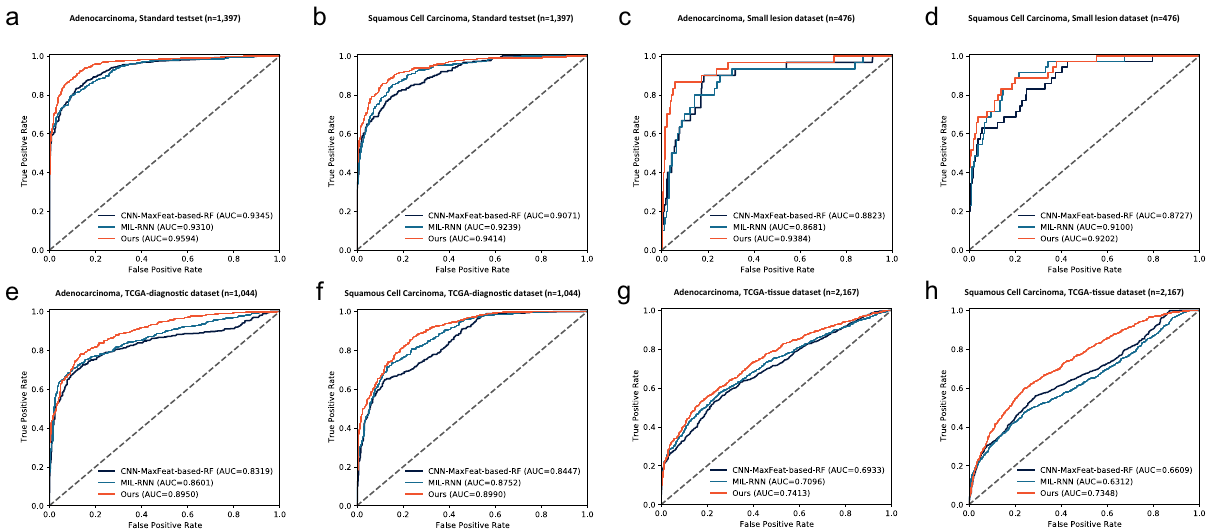
Fig. 2 Receiver operating characteristic (ROC) curves of methods on classifying adenocarcinoma and squamous cell carcinoma. Area under the ROC curve (AUC) was measured for each data set and method. All the measurements were taken from distinct samples. a , b ROC curves on the standard testing data set ( n = 1397). c , d ROC curves on the small lesion data set ( n = 476). e , f ROC curves on TCGA-diagnostic data set ( n = 1044). g , h ROC curves on TCGA-tissue data set ( n = 2167). The dark blue, cyan, and red lines represent CNN-MaxFeat-based RF, MIL-RNN, and whole-slide training method, respectively.